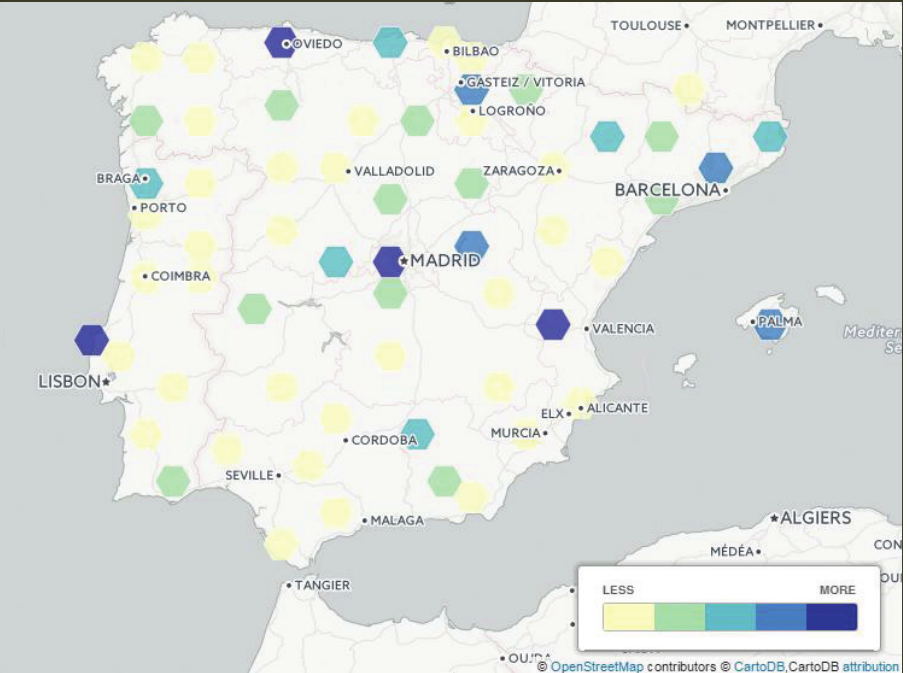
Figure 4. Geographic distribution. Records grouped by provinces, georeferenced